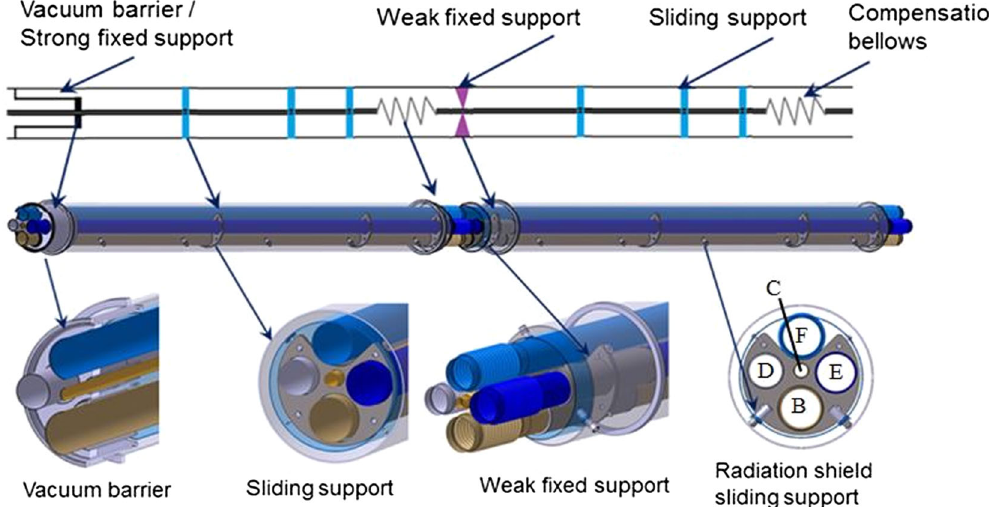
FIG. 3. Schematic view of two 12 m modules included in the 50 m section of a cryogenic transfer